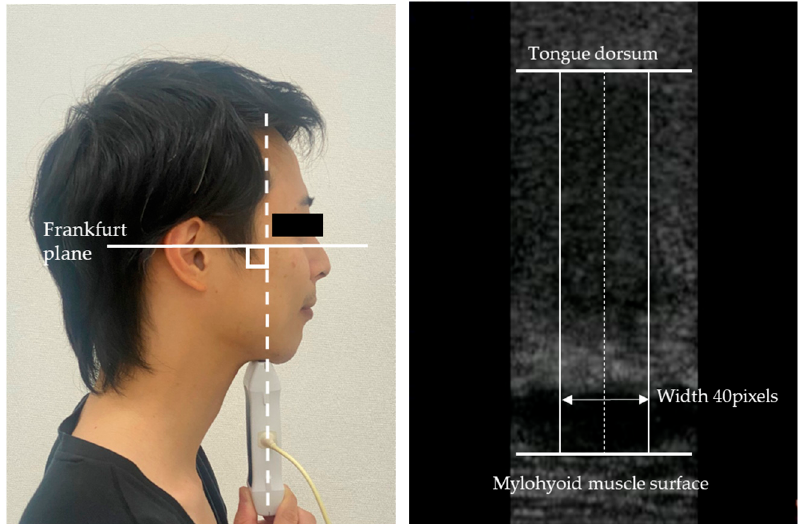
Figure 1. Echo intensity measurement of tongue using ultrasonography. Probe and head position ( left ), and measurement of echo image ( right ).